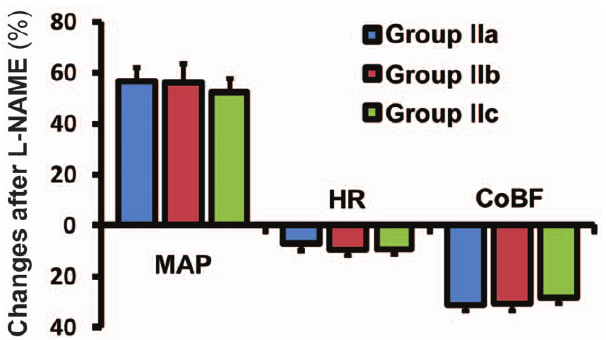
Figure 1. NO synthase blockade increases mean arterial pressure (MAP), while decreases heart rate (HR) and cerebro- cortical blood flow (CoBF). Mean 6 SEM percentual changes are shown after NO synthase inhibition by 100 mg/kg of L-NAME, compared to the steady state pre-injection values presented on Table 1 (n=10, 6 and 7 in the case of MAP and HR, and n=20, 12 and 14 in the case of CoBF in Groups IIa., IIb. and IIc., respectively).